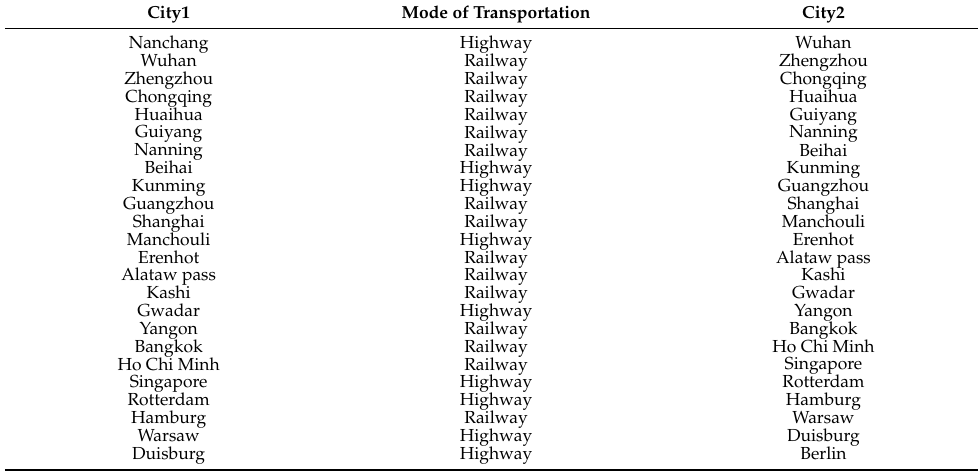
Figure 14. AGA algorithm carbon emissions target iteration curve. Table 8. Optimizing the optimal path of multimodal transport by the AGA